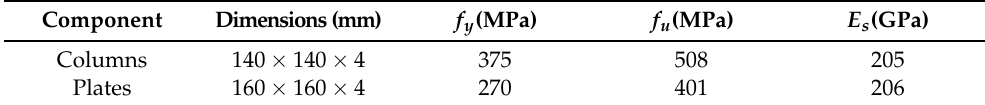
Table 1. Mechanical properties of steel structural components.